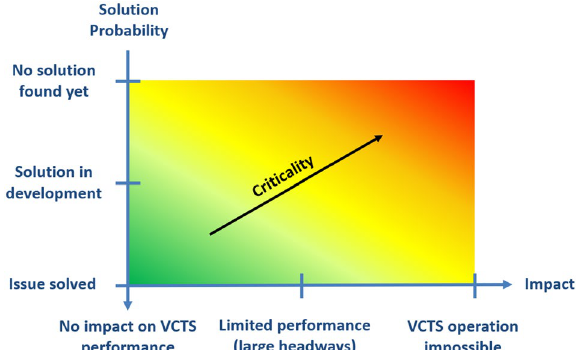
Figure 4. Criticality matrix, qualitative approach to evaluate obstacles for the VCTS